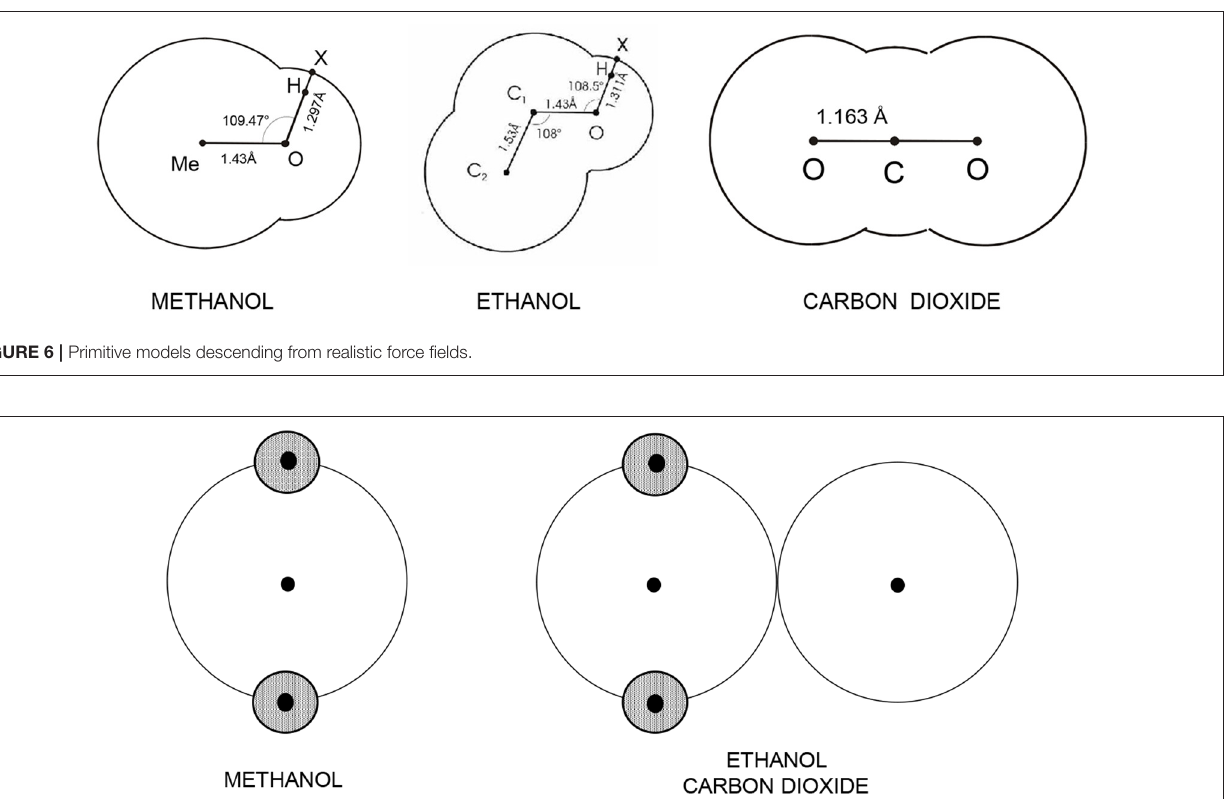
FIGURE 7 | Intuitive primitive models used in SAFT modeling. Shaded circles denote Coulombic interaction